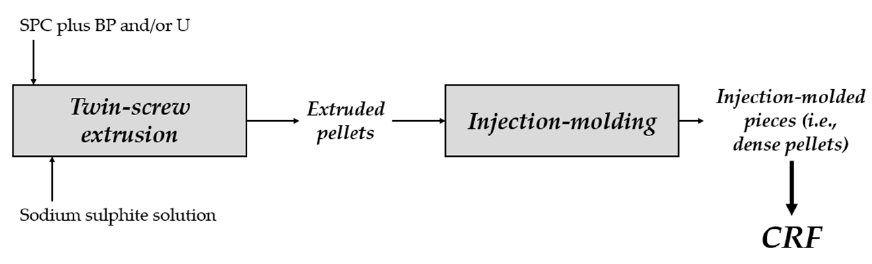
Figure 2. Schematic diagram of the process developed for the preparation of the fertilizers.